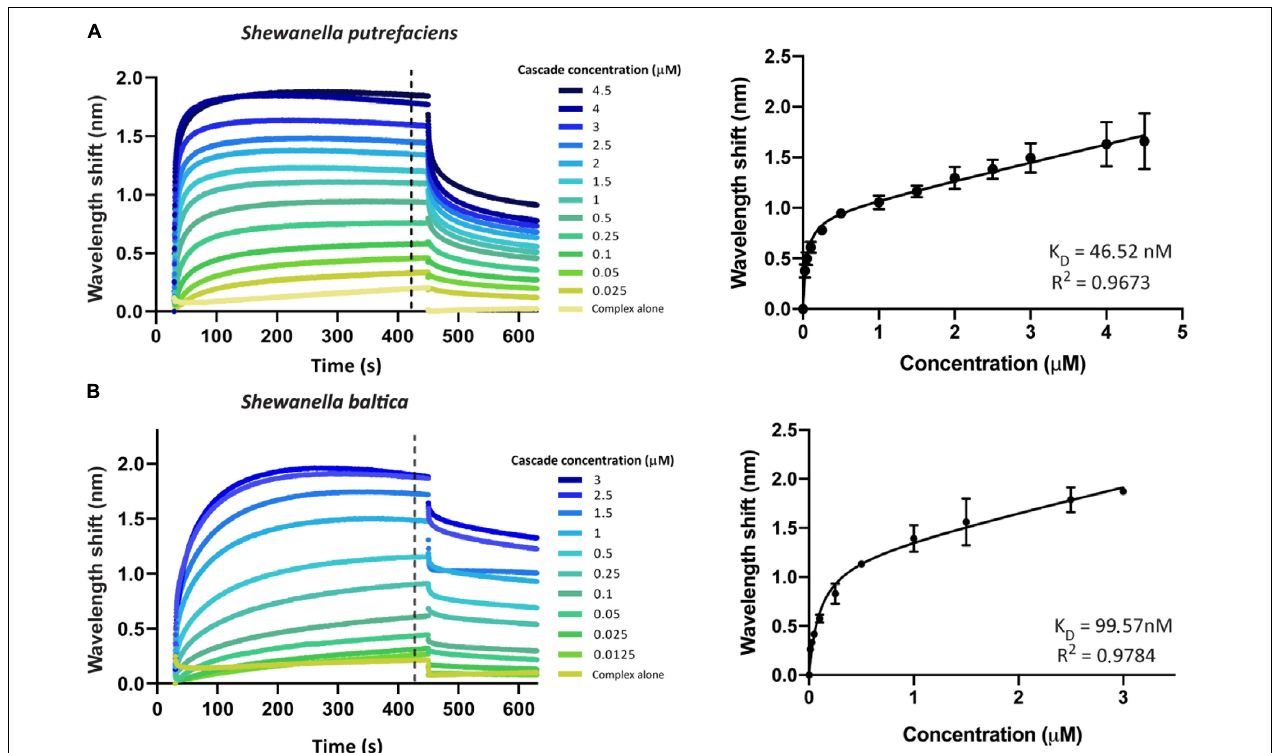
FIGURE 3 | Determination of the equilibrium dissociation constants (K D ) of the interactions of Type I-Fv and I-F CRISPR-Cas complexes with target dsDNA. Wavelength shift (nm) generated by the addition of Type I-Fv Cascade from S. putrefaciens CN-32 (A) or Type I-F from S. baltica OS195 (B) to complementary dsDNA oligonucleotide immobilized on a streptavidin biosensor at a concentration of 100 nM. Binding was followed for 7 min in order to reach equilibrium. Afterward, the protein-bound biosensor was incubated for 3 min in buffer to measure the dissociation reaction. The interaction of the complexes with the dsDNA-free biosensor is shown as control (Complex alone). The wavelength shifts recorded at 420 s after the start of binding were plotted against the corresponding complex concentration in order to calculate the respective K D values. Data were fitted to the non-linear equation: Y = B max *X/(K D + X) + NS*X, where B max is the maximum wavelength shift and NS the slope of the non-linear component, representing non-specific binding. The coefficients of determination ( R 2 ) and K D values obtained are shown in the graphs for each complex. Binding assays were performed in duplicate. Error bars indicate the Standard Error of the Mean